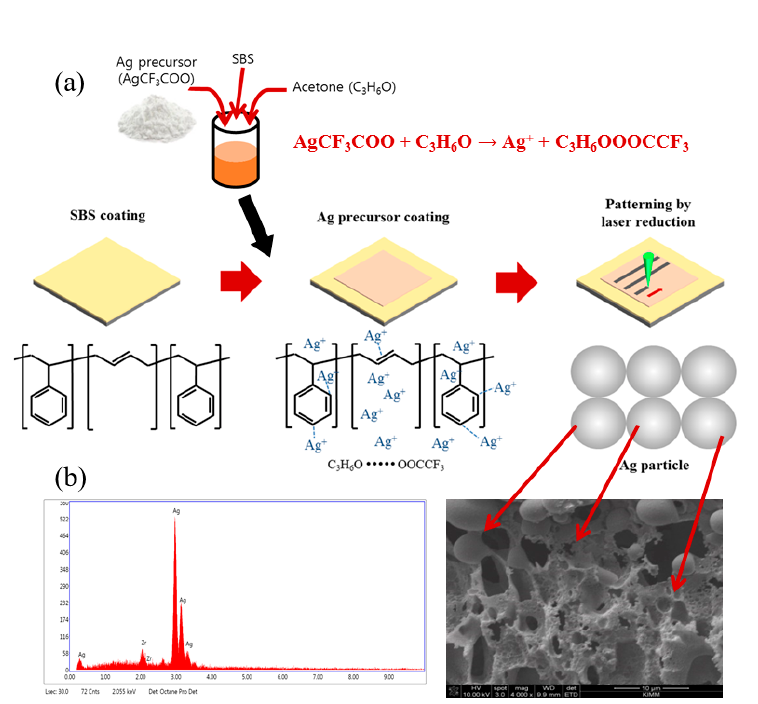
Figure 1. Schematic of the patterning process ( a ) and EDX analysis and SEM image of pattern obtained by laser reduction of Ag precursor ( b ).